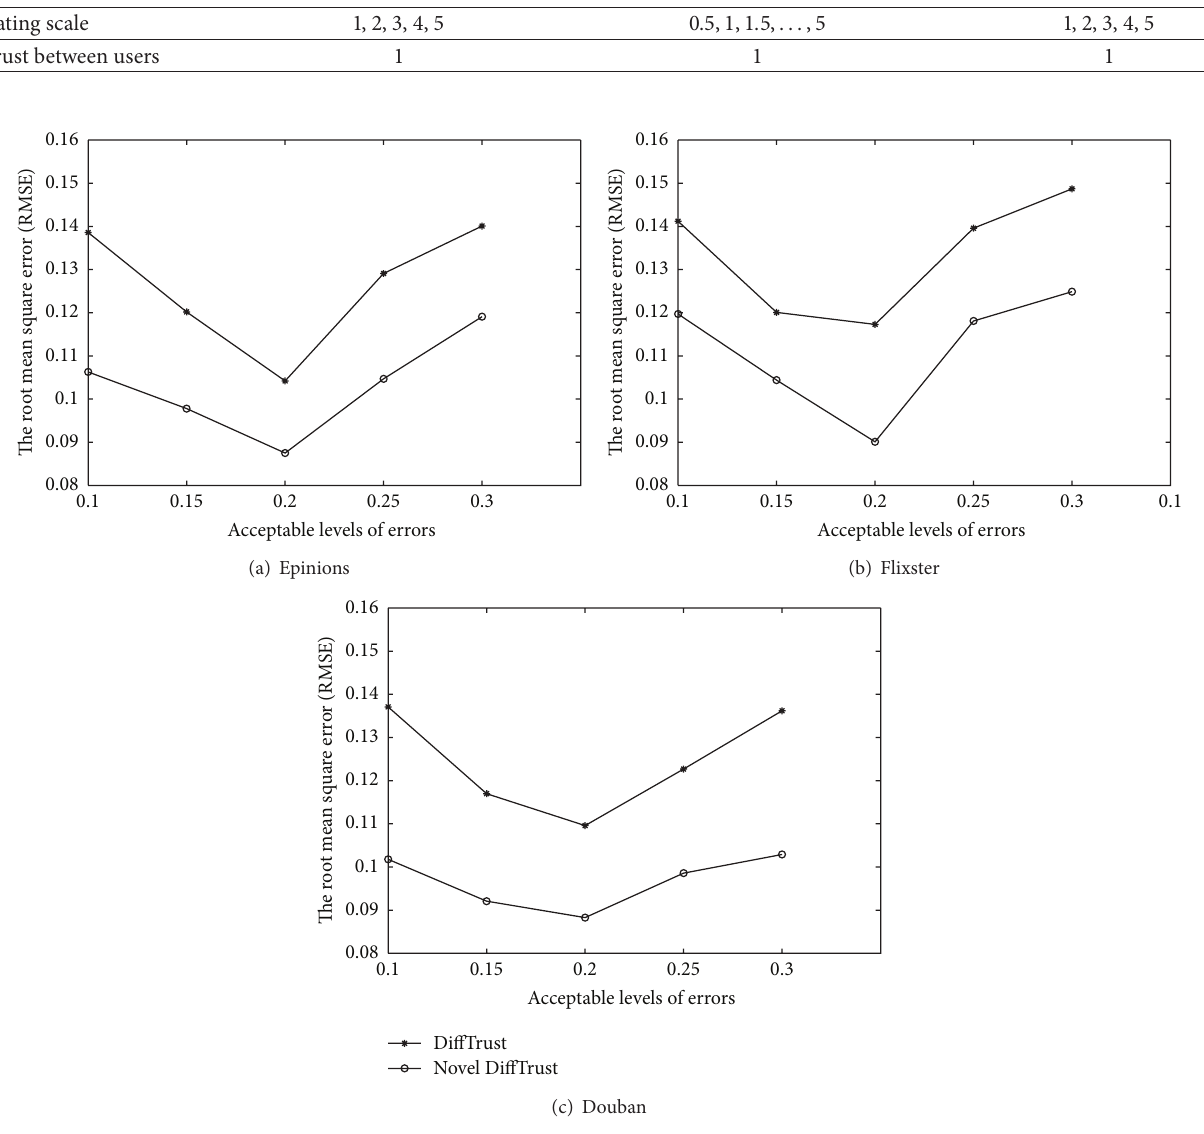
Figure 4: Impacts of 𝜀 on